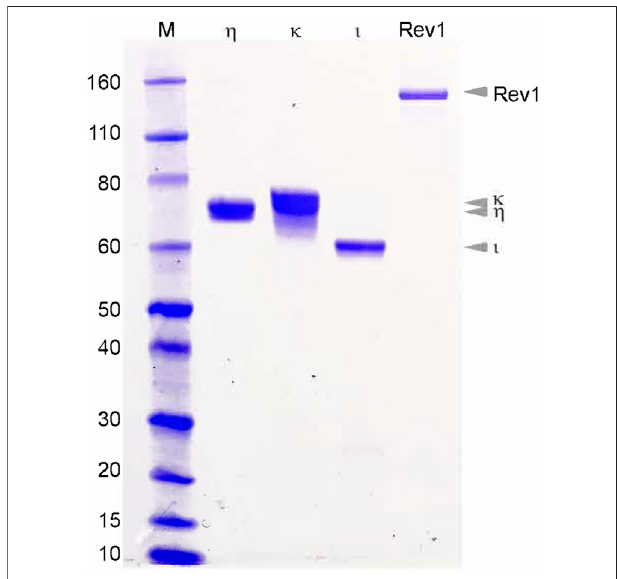
FIGURE2| Puri fi ed T.languinosus polymerases η , κ , ι andRev1.Twoto fi ve μ g of the fi nal puri fi ed polymerases were separated on a 12% SDS-PAGE gel. Visual analysis suggests each polymerase is greater than 95%